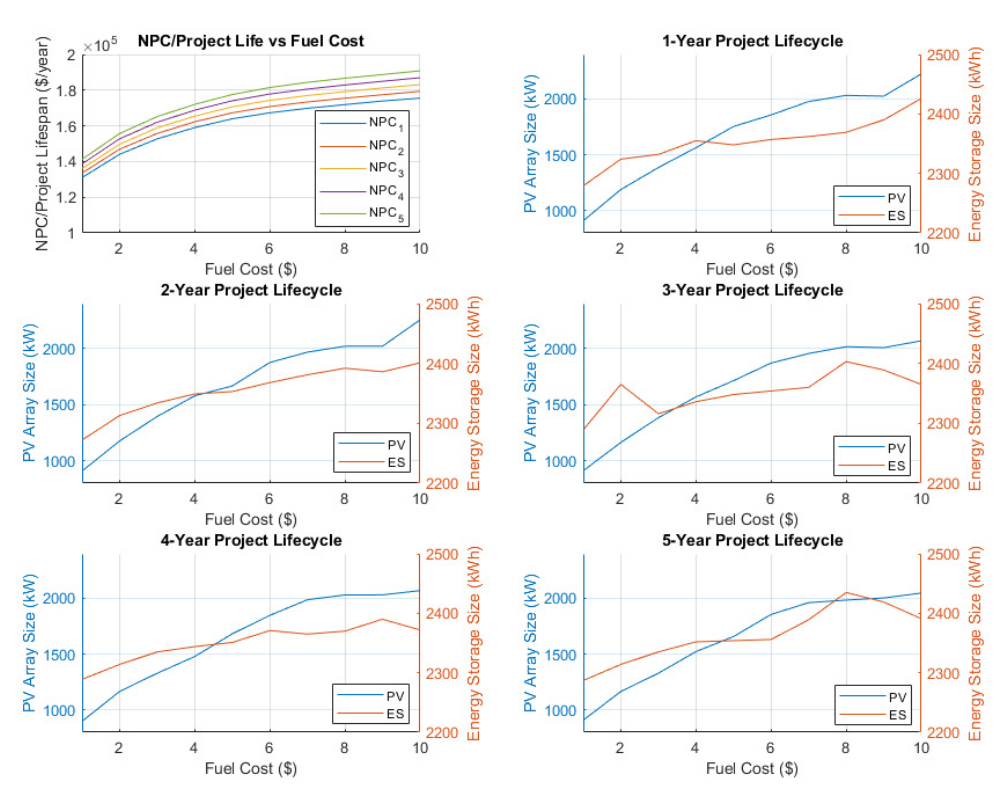
Figure 9. Sensitivity analysis of the HES optimization. The top-left chart shows the net present cost sensitivity for one-year (NPC 1 ) through a five-year (NPC 5 ) project life. The remaining charts show the dependence of the optimal photovoltaic (PV) array size and energy storage (ES) size for fuel prices varied between $1–10/L and project lifecycles varied from 1–5 years.